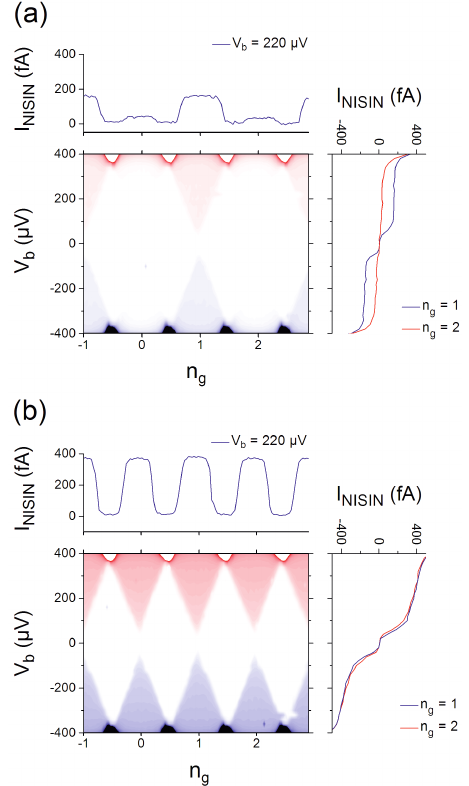
Figure 5. Detector current, I NISIN , measured as a function of the gate and bias voltages at zero magnetic field, ( a ) without irradiation and ( b ) under irradiation, when the source voltage is set to V JJ ≈ 200 µV > E even /2 e generating microwave signal with frequency f J ≈ t